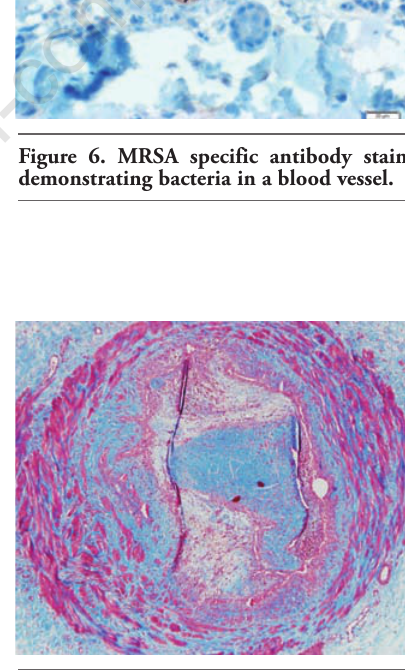
Figure 9. Thrombus in anterior tibial artery (Trichrome stain, 100 ¥ magnification).